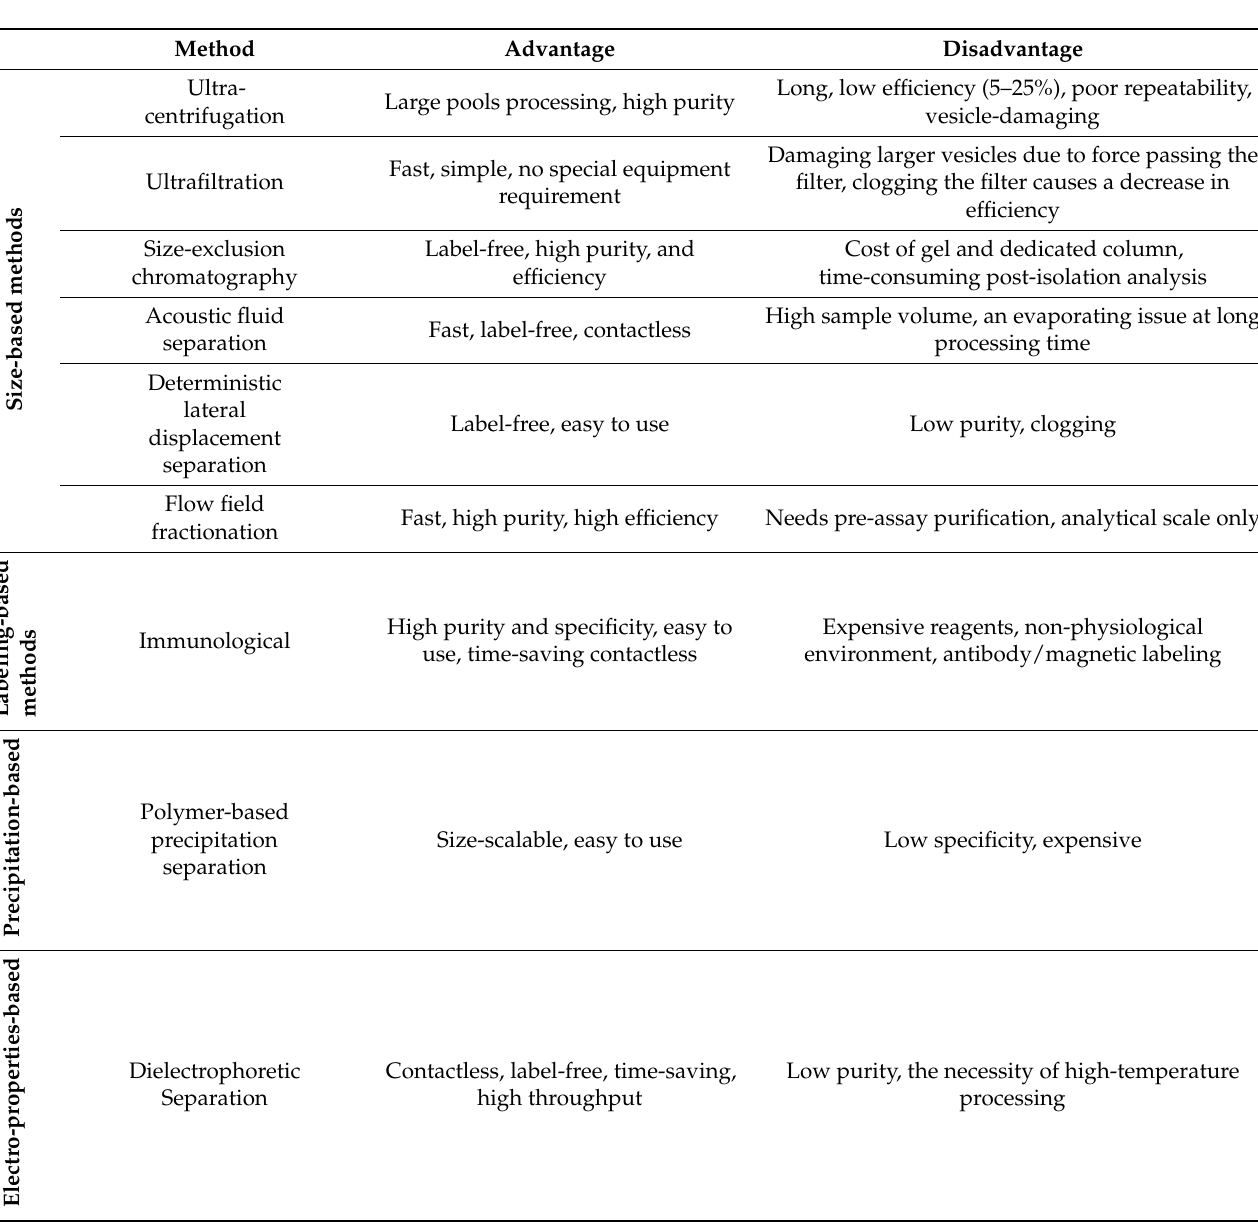
Table 1. Exosome isolation